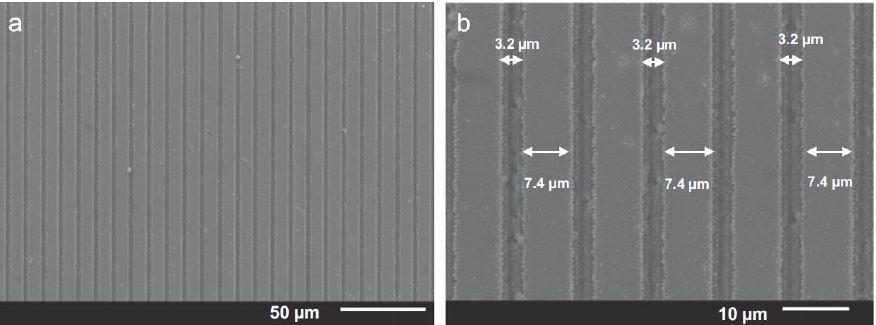
Figure 14. SEM images of interdigitated gold electrode fingers microfabricated using femtosecond-laser pulses. An overview image ( a ) and finger details ( b ) with distance measurements are shown in the figure. Reprinted with permission from [126]. Copyright (2015), Elsevier.